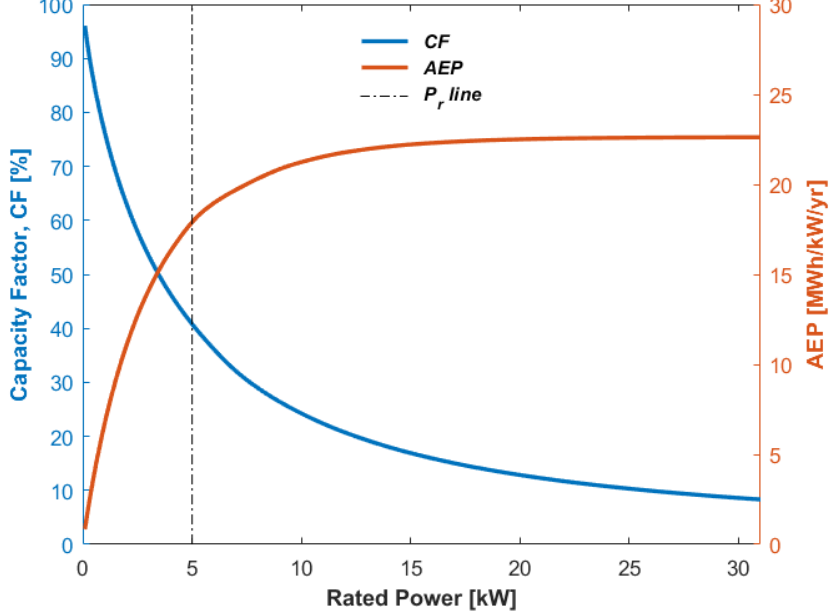
Figure 17. Annual energy production and capacity factor against rated power at − 3° pitch angle. The relative- CoE was calculated based on Equation (31) and by employing the AEP values at the respective rated power from Figure 17. In Figure 18, the relative- CoE is shown as a function of rated power and wind speed. Figure 18a shows the blade being used for a direct drive system, while in Figure 18b, the same blade is used for a gear drive system. The values for the direct drive system demonstrate the lowest relative- CoE at the selected design parameters. Figure 18a confirms that a P r of 5 kW and V r of 10 m/s were at the minimum relative- CoE values. Running the turbine at lower-rated power (<5 kW) would increase the CoE . This is due to the significant reduction in AEP compared to the reduction in cost at lower-rated power. Operating at higher-rated power (>5 kW) would also increase the CoE